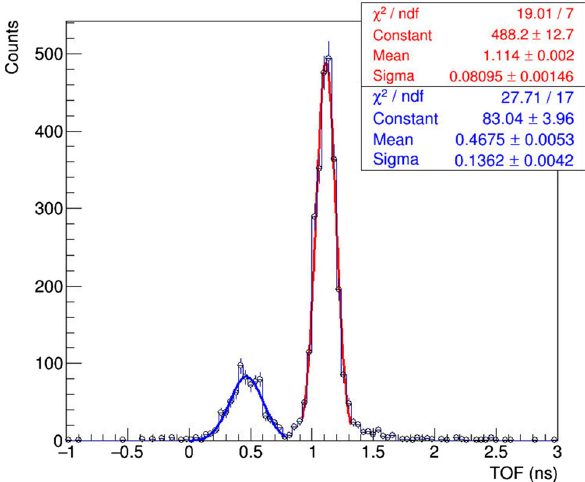
Fig. 8 The distribution of time of flight, TOF = ( T 1 + T 2 − T 3 − T 4 ) peak fitted with blue line are pions and the other read peak are protons